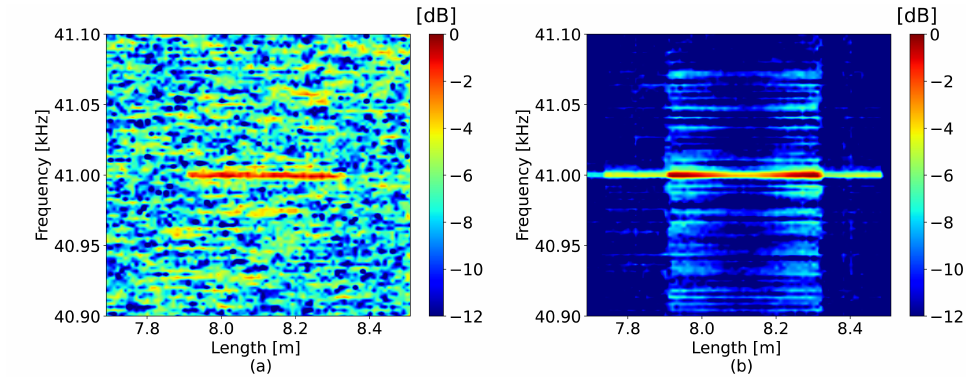
Figure 3. 41 kHz perturbation detected by ( a ) the standard method and ( b ) the neural